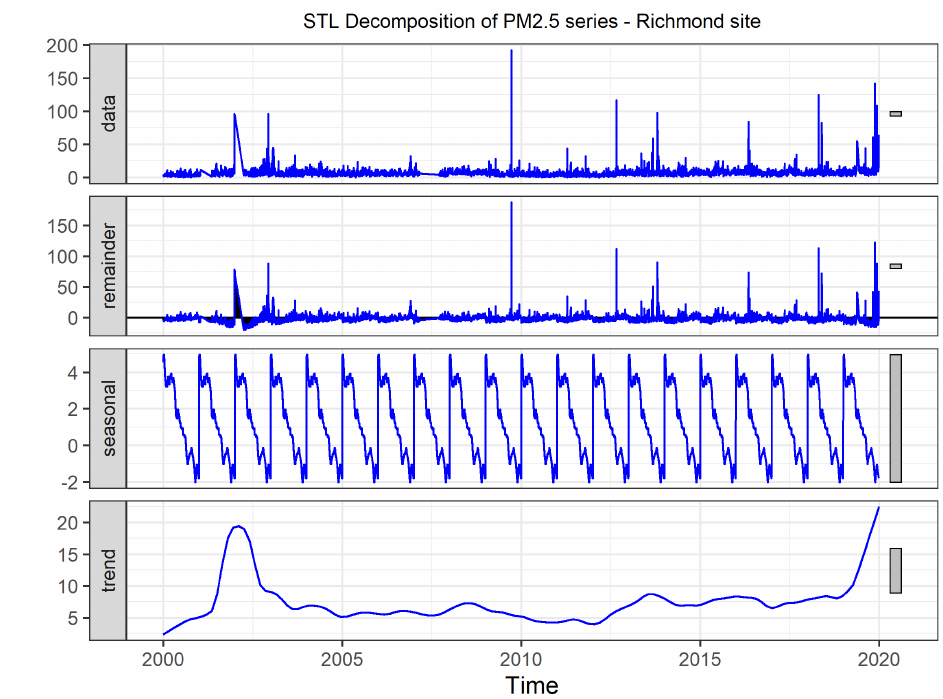
Figure 1. Decomposition of a time series into trend, seasonal, and remainder components: Top panel shows the original time series. The second panel shows the remainder. The third panel shows the seasonal component. Bottom panel shows the trend